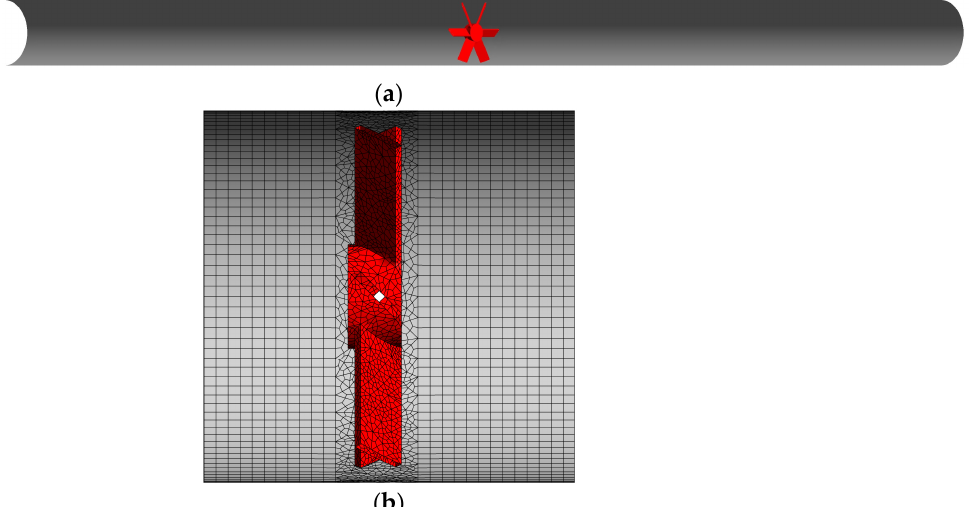
Figure 1. ( a ) Cutaway drawing of the pipe with the compact static mixer in red. The gas–liquid mixture enters from the left pipe opening. ( b ) Details of the mesh close to the static mixer.